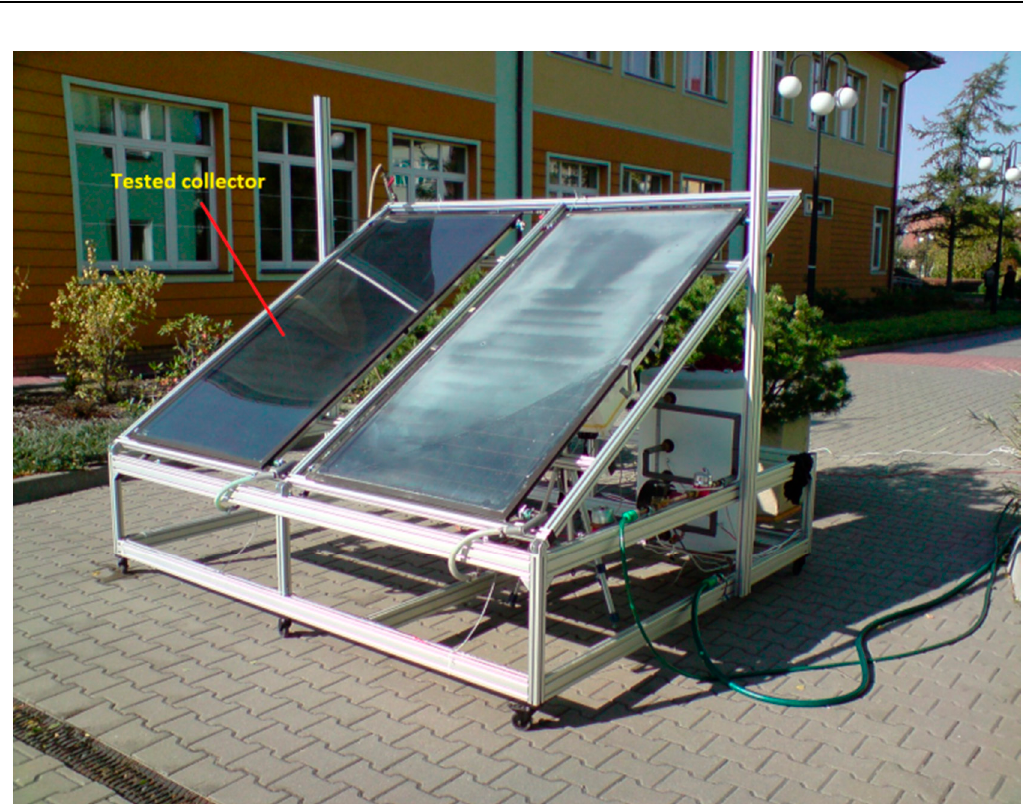
Figure 3. Test stand (system I).